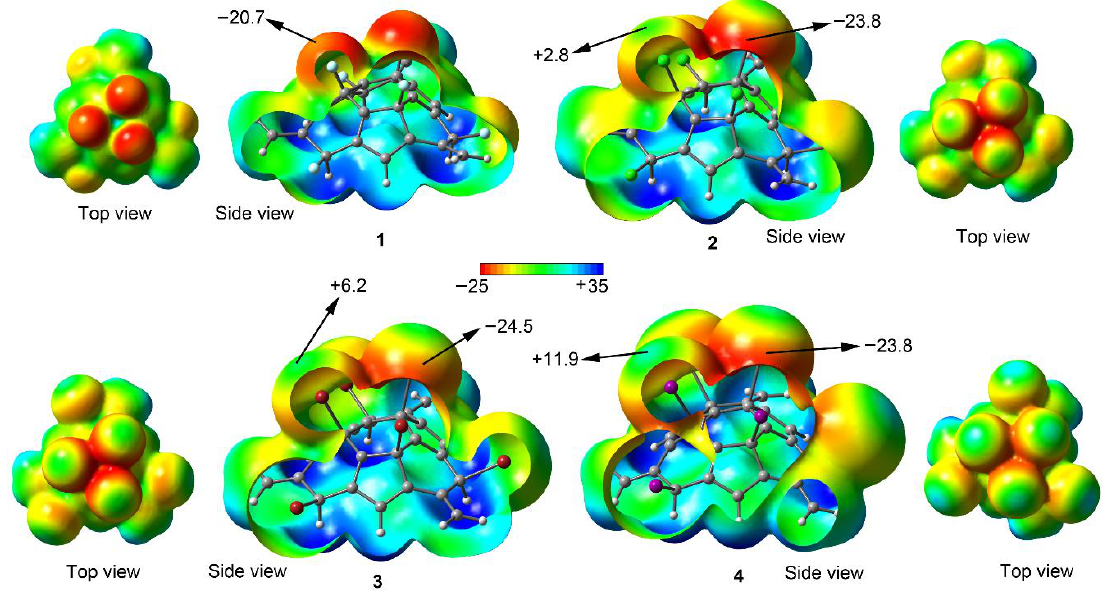
Figure 2. Molecular electrostatic potential (MEP) surfaces of compounds 1 to 4 used in the study. Energies at selected points of the surface (0.002 a.u.) are given in kcal/mol.